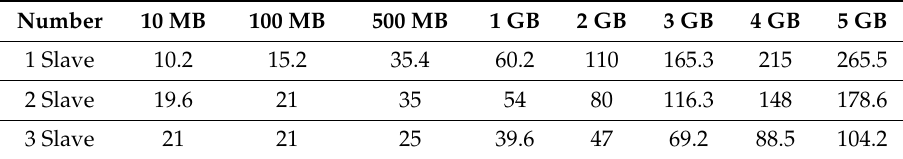
Table 12. The diagnostic times under different slave